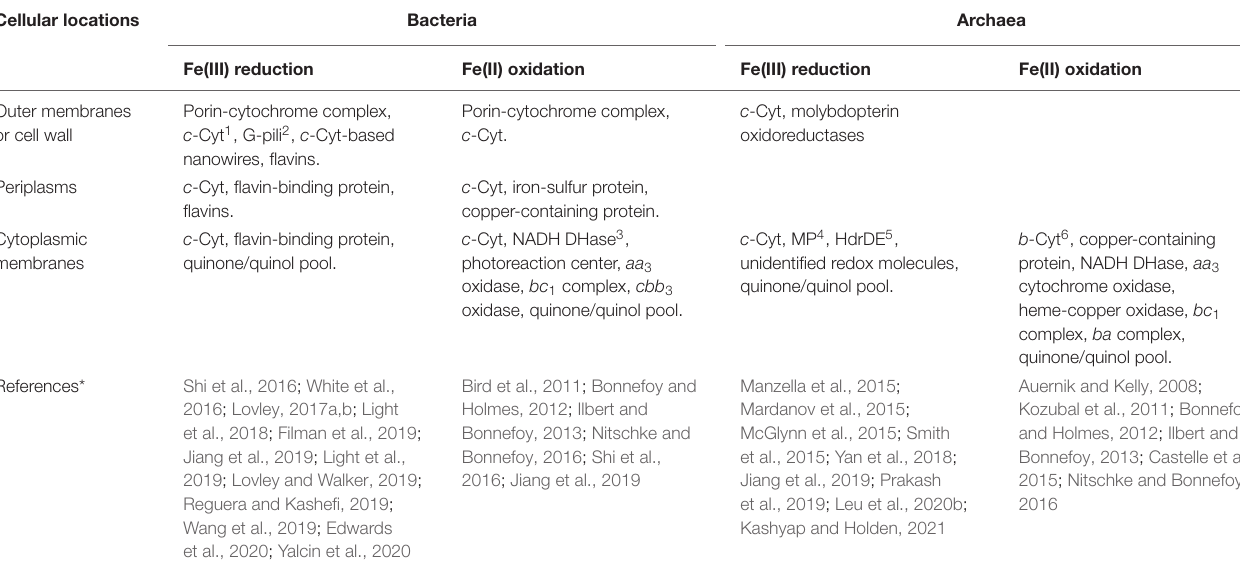
TABLE 1 | Comparison of different types of proteins and redox molecules that are or are suggested to be involved in Fe(III) reduction or Fe(II) oxidation by bacteria and archaea. Cellular